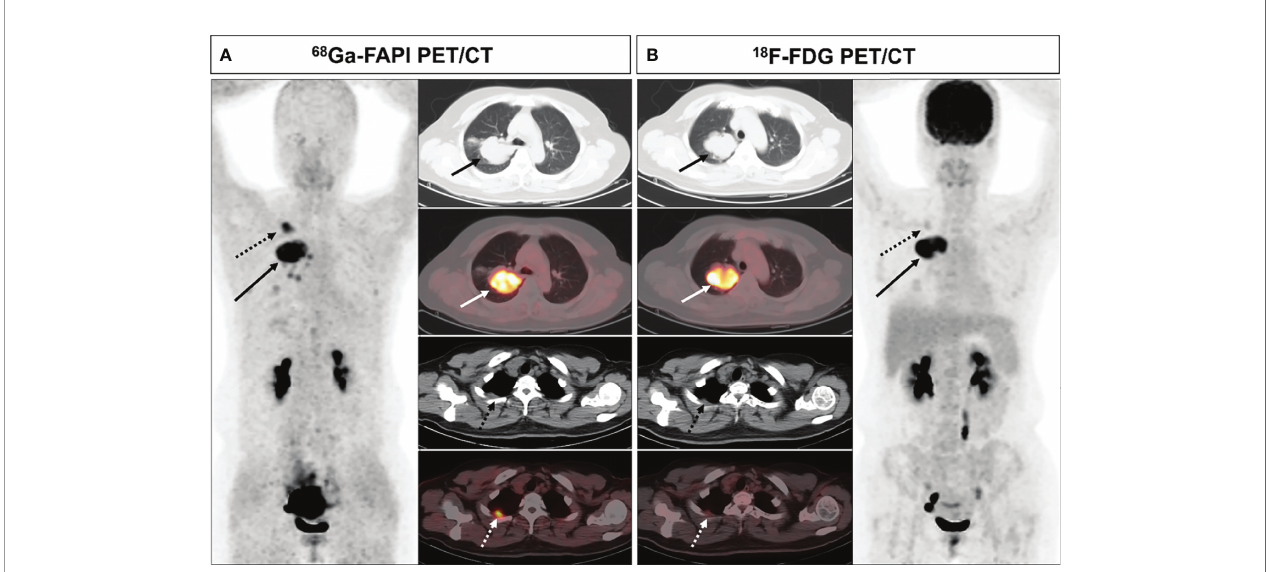
FIGURE 2 | A 44-year-old female (patient 1) diagnosed with adenocarcinoma. 68 Ga-FAPI PET/CT (A) revealed increased FAPI uptake in the primary lesion (solid arrows, SUVmax = 11.7) and pleural lesion (dashed arrows, SUVmax = 7.0). 18 F-FDG PET/CT (B) also showed high FDG uptake in the primary lesion (solid arrows, SUVmax = 12.4), while the pleural lesion with only mild FDG uptake (dashed arrow, SUVmax = 2.2). The pleural lesion was deemed likely to be metastatic, as con fi rmed upon subsequent follow-up.